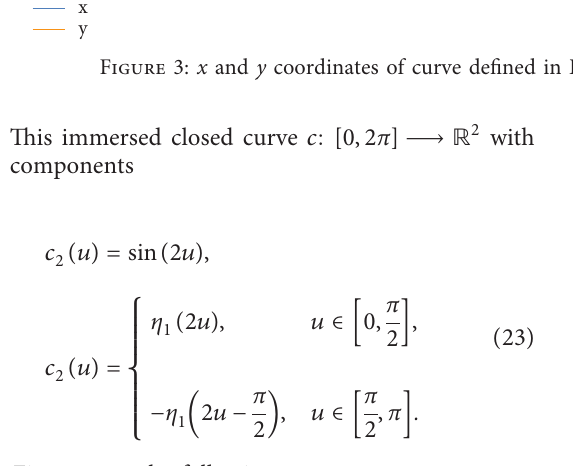
Figure 3: x and y coordinates of curve defined in Example 2; trace of curve defined in Example 2.